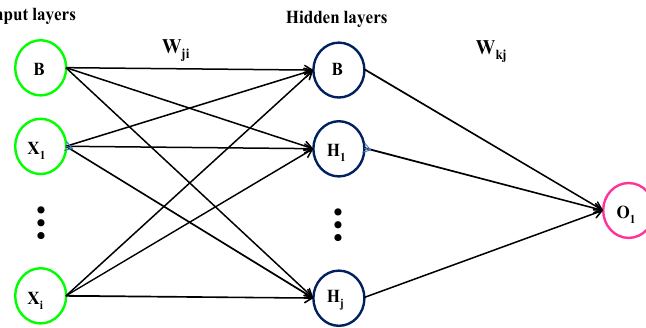
Figure 3. An example schematic of a feedforward network.